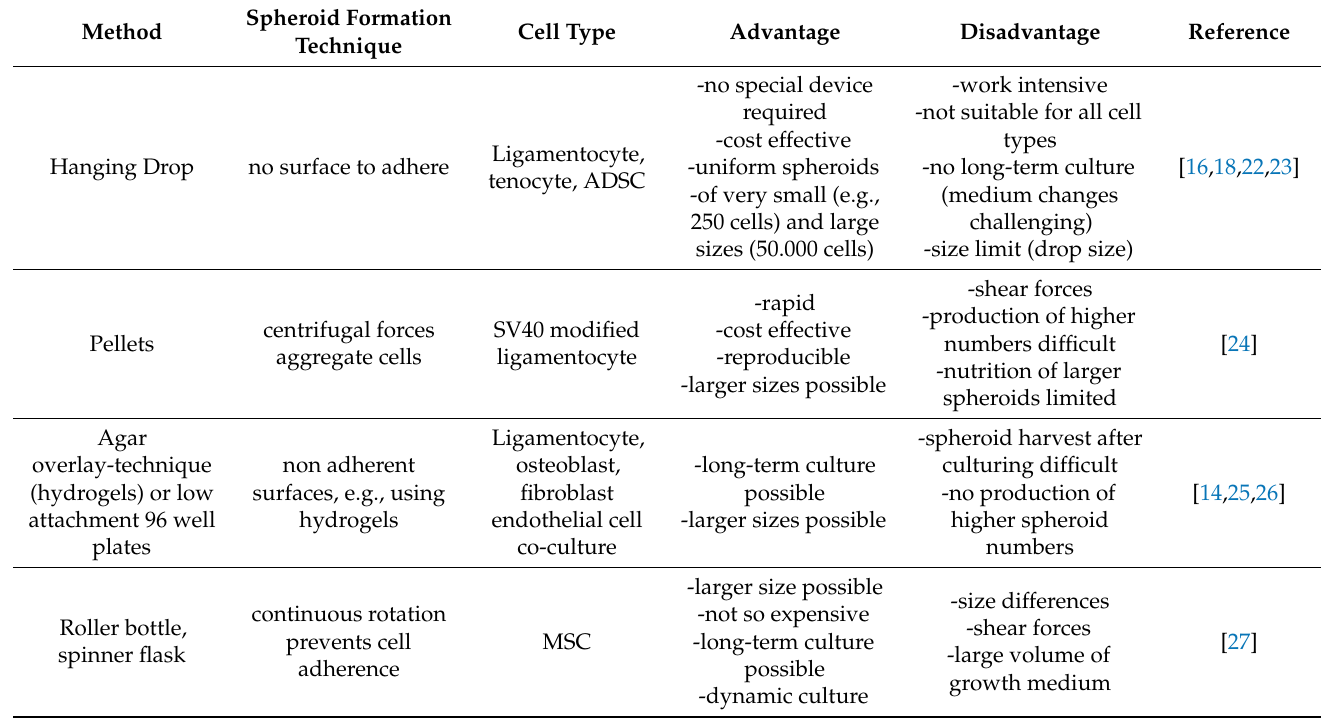
Table 1. Synopsis of techniques used for spheroid formation based on ligamentocytes, tenocytes, and stem